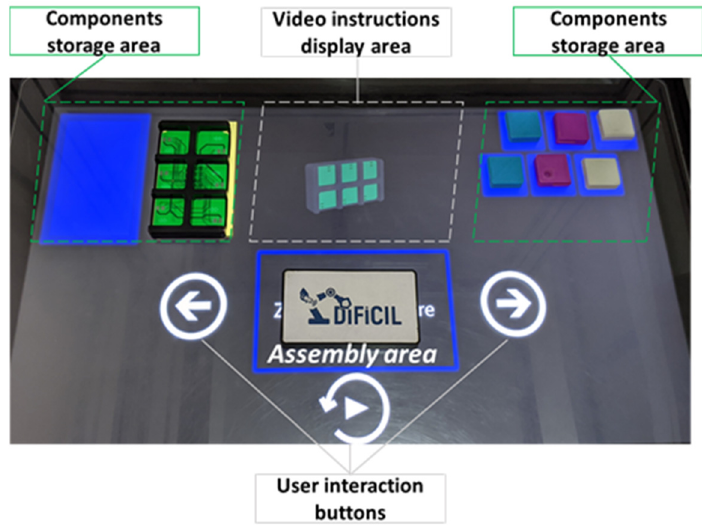
Figure 3. User interface of the assembly assistance prototype.